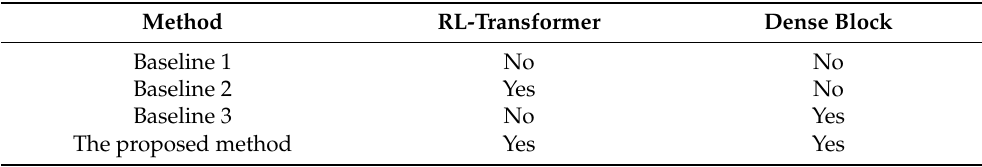
Table 4. Characteristics of the